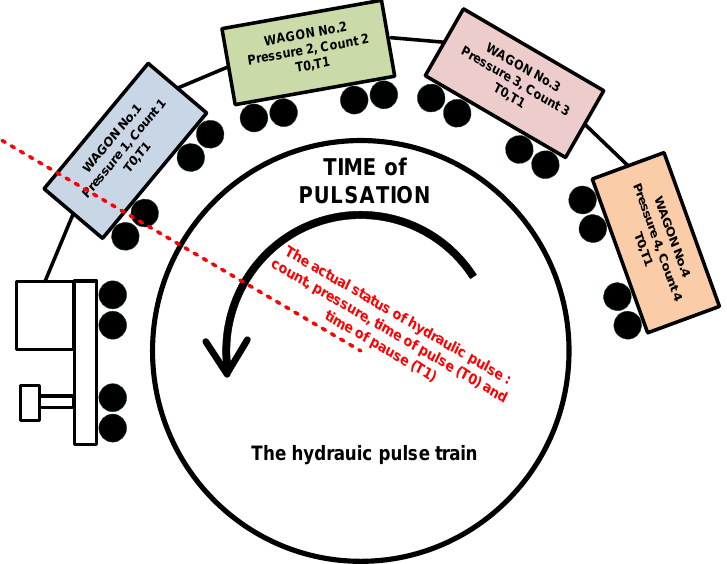
Figure 1. Pneumatic – hydraulic pulse train-schematic represents of cyclic repeating sequence pulses for hydraulic pulse system as cyclic paths of train with four wagons, each with four passengers.